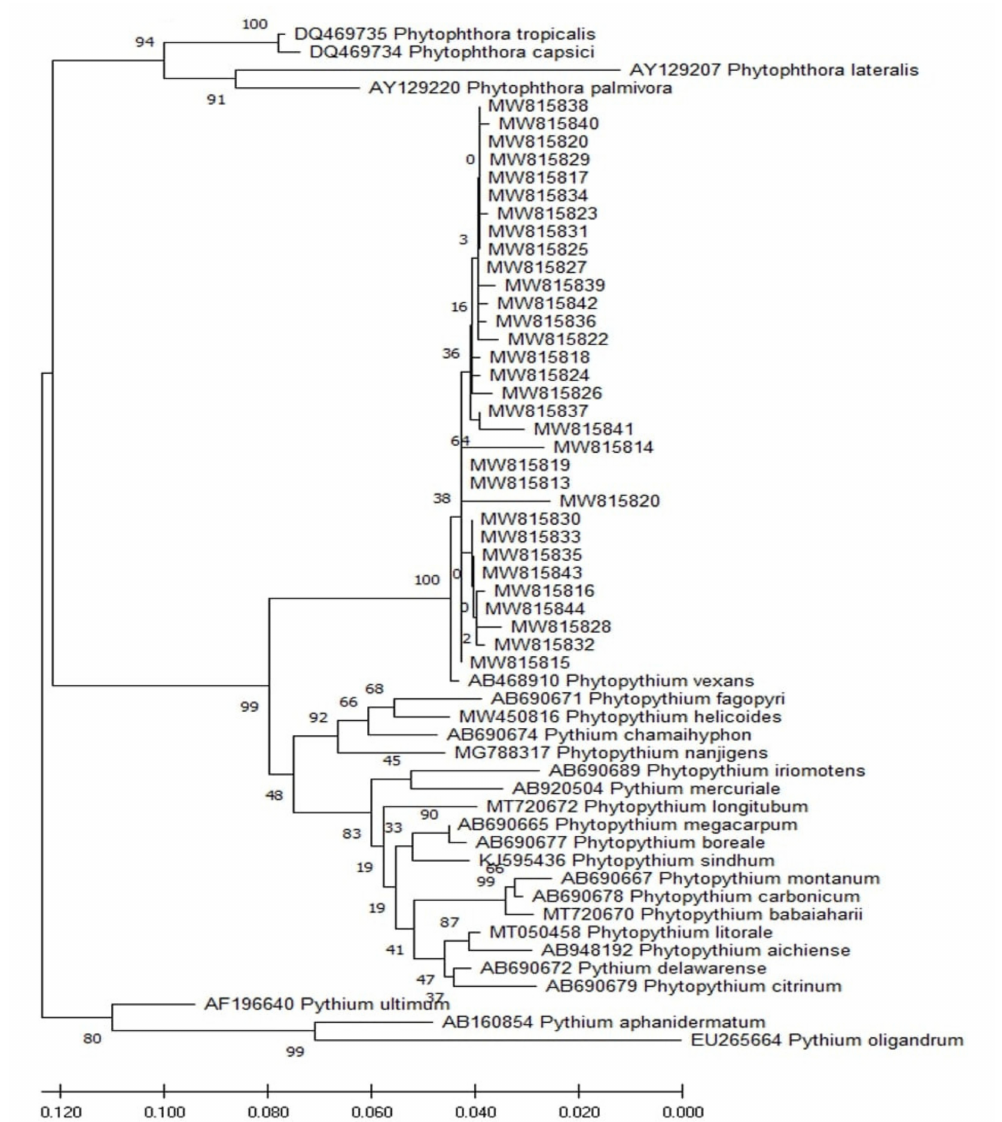
Figure 4. Phylogenetic tree of oomycetes fungi Pp. vexans was constructed using the maximum likelihood method on their cytochrone oxidase subunit II sequences, showing the position of our oomycetes isolates that were obtained in this study within the Phytopythium and P ythium complex. Isolates from this study are indicated in bold characters. The sequences of Phytopythium , Phytophthora and Pythium from Genebank; Pp. vexans ( AB468910 ) , Pp. helicoides ( MW450816 ) , Pp. sindhum ( KJ595436 ) , Pp. litorale ( MT050458 ) , Pythium mercuriale ( AB920504 ) , Phytophthora tropicalis ( DQ469735 ) , Phytophthora capsici ( DQ469734 ) , Phytophthora lateralis ( AY129207 ) , Phytophthora palmivora , ( AF196640 ) Pythium ultimum ( AF196640 ) , Pythium aphanidermatum ( AB160854 ) , Pp. aichiense ( AB948192 ) , Pp. babaiiaharii ( MT720670 ) , Pp. boreale ( AB690677 ) , Pp. carbonicum (AB690678) , Pp. chamaehyphon (AB690674) , Pp. citrinum (AB690679) , Pp. delawarense ( AB690672 ) , Pp. fagopyri ( AB690671 ) , Pp. iriomotense ( AB690689 ) , Pp. longitubum ( MT720672 ) , Pp. megacarpum ( AB690665 ) , Pp. montanum ( AB690667 ) , Pp. nanjigens ( MG788317 ) , Pp. oedochilum ( AB690676 ) , and Pythium oligandrum ( EU265664 ) , were used as references. Numbers at the nodes of clusters represent the bootstrap values that were generated from 1000